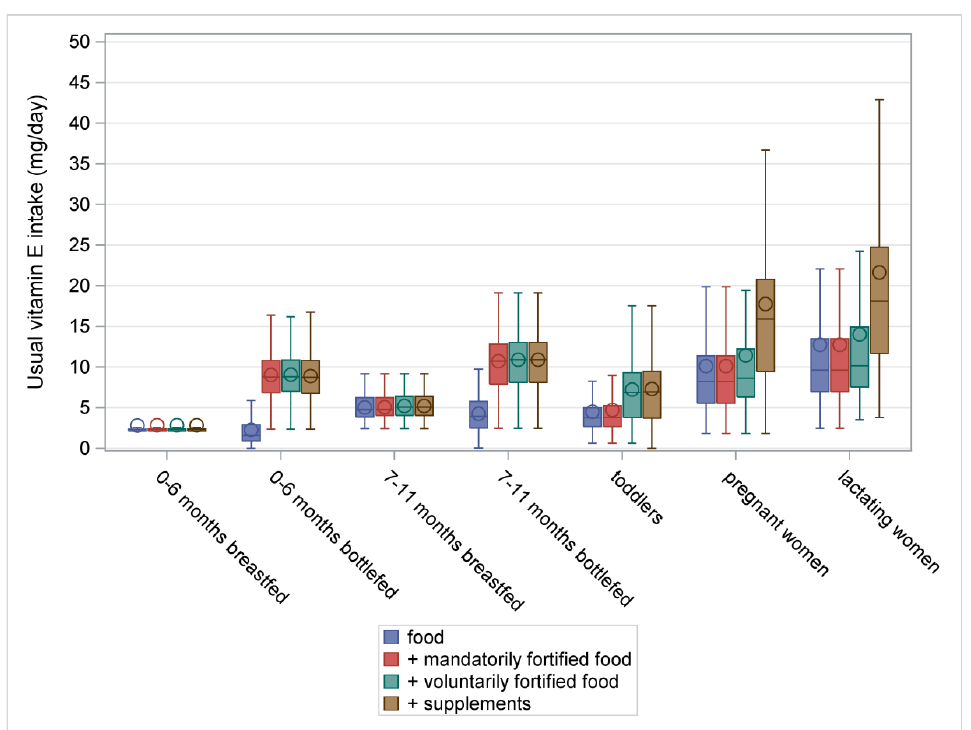
Figure 3. Usual intake of vitamin E (mg/day) from food, fortified food, and supplements in infants, toddlers, pregnant women, and lactating women from a Belgian study on the intake of vitamins A, D, E, and K (VITADEK-study) 2015.